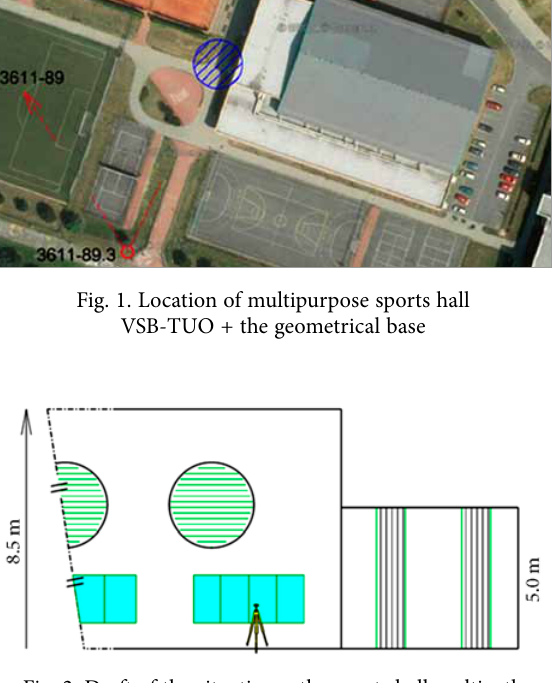
Fig. 2. Draft of the situation – the sports hall multipath